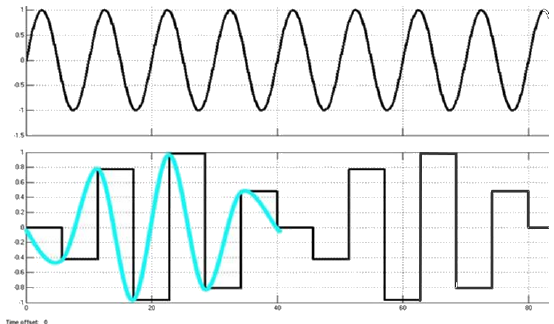
Fig. 7. The results of experiments at a maximum sampling frequency